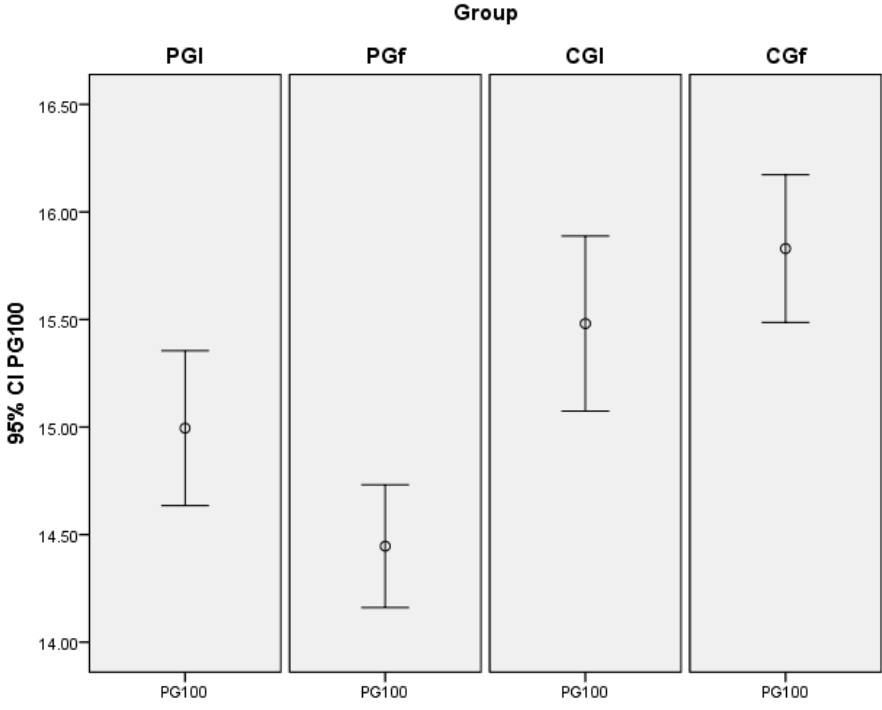
Figure 3. Speed 100 m means between the PG and CG group.